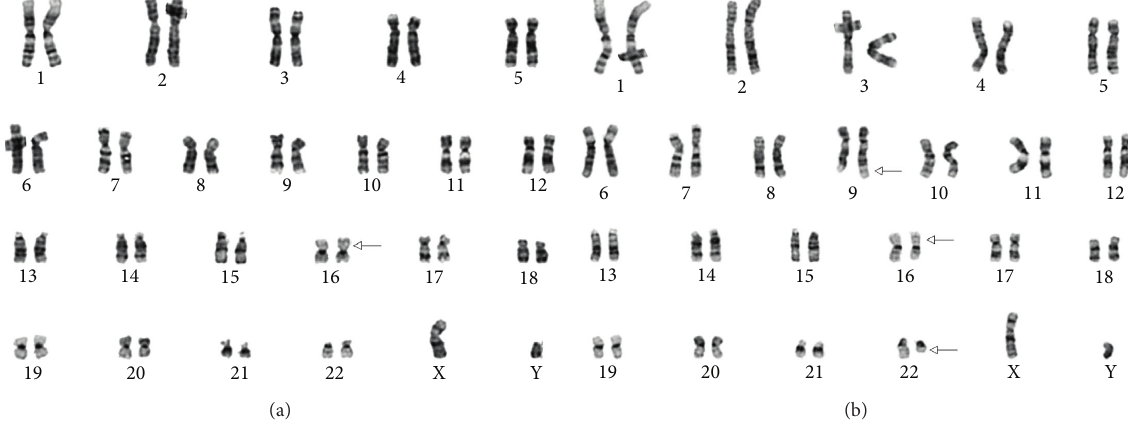
Figure 2: Representative G -banded karyogram showing (a) the inv(16)(p13.1q22) as a sole abnormality and (b) co-occurrence of inv(16)(p13.1q22) and t(9;22)(q34; q11.2). The arrows indicate the rearranged